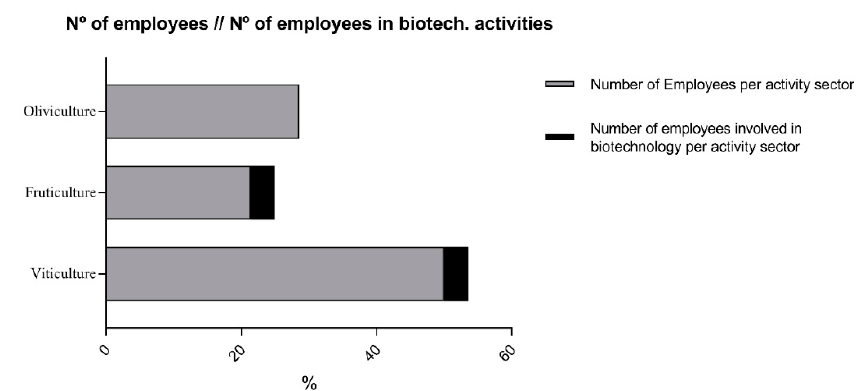
Figure 2. The number of employees vs the number of employees in biotechnology activities. Source: Author’s calculation from the research dataset.